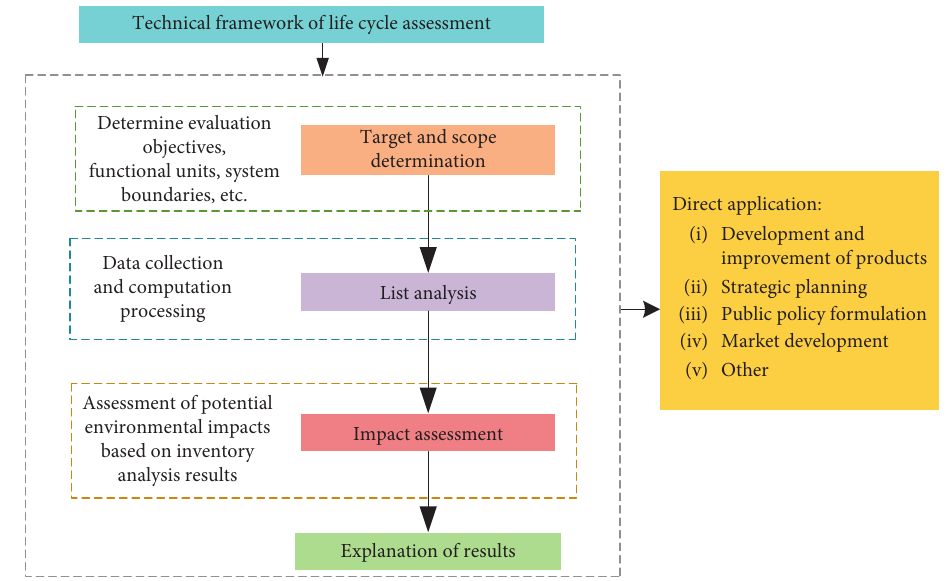
Figure 1: Technical framework for life-cycle